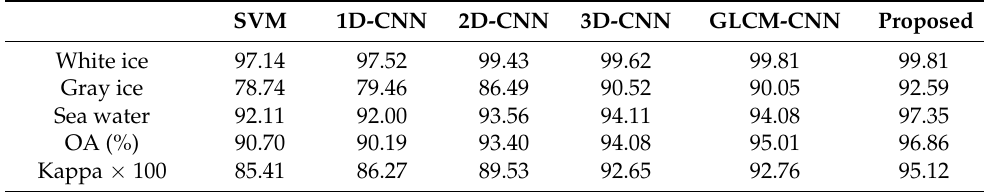
Table 10. Classification results (%) of the Baffin Bay data set.